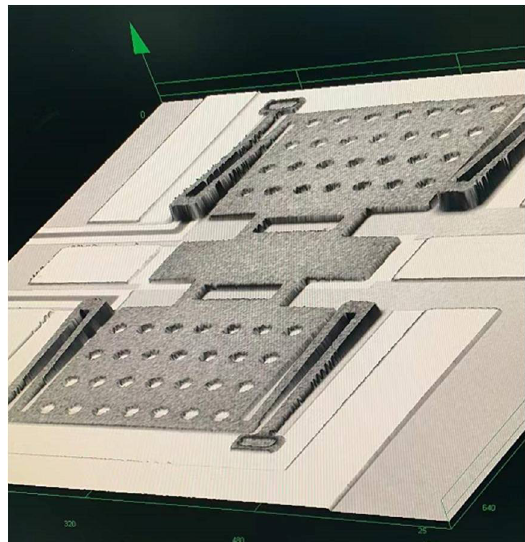
Figure 11. Micrograph of the fabricated MEMS switch.